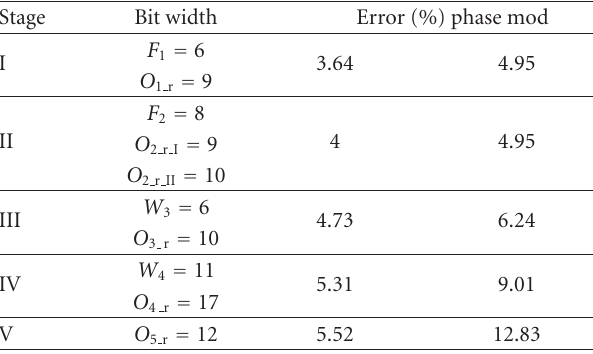
Table 1: Parameters of each stage (100% density).